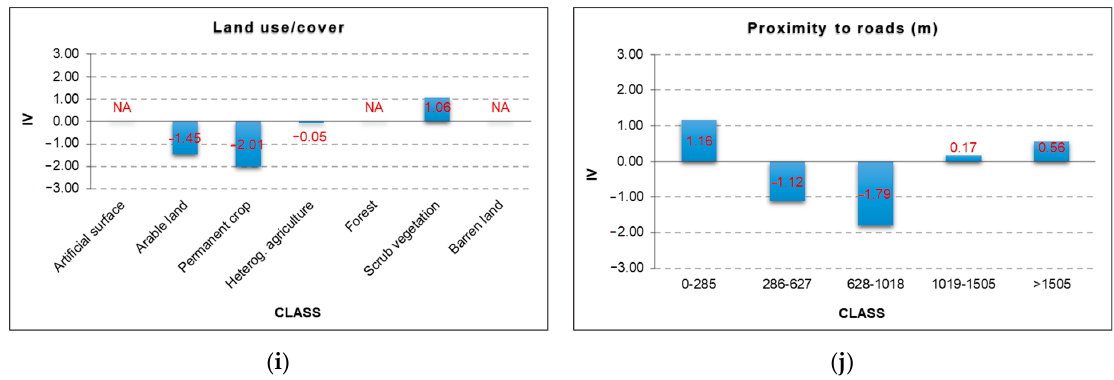
Figure 5. The estimated IVs for the classes of conditioning factors qualified from the factor selection: ( a ) altitude; ( b ) slope angle; ( c ) plan curvature; ( d ) stream density; ( e ) TWI; ( f ) lithology; ( g ) proximity to faults; ( h ) soil type; ( i ) land use/cover; ( j ) proximity to roads. NA values (or no bars) indicate “not applicable” for these classes.